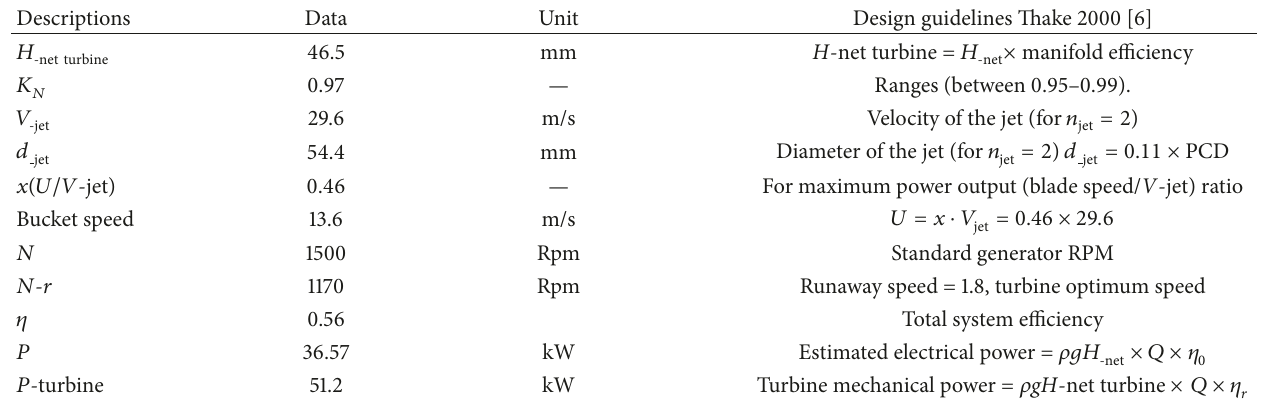
Table 5: Basic design calculation summary of Pelton turbine.